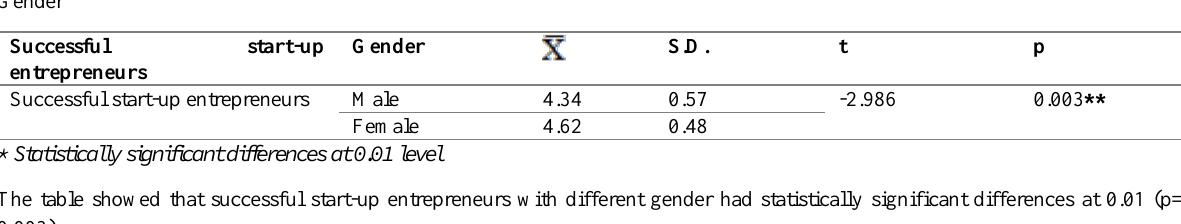
Table 5: Comparison of desired characteristics of successful start-up entrepreneurs in Prachuap Kirikhan province according to Gender